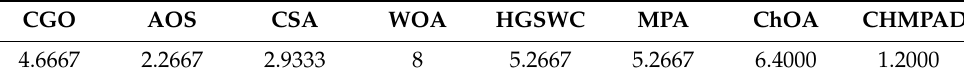
Table 8. Friedman